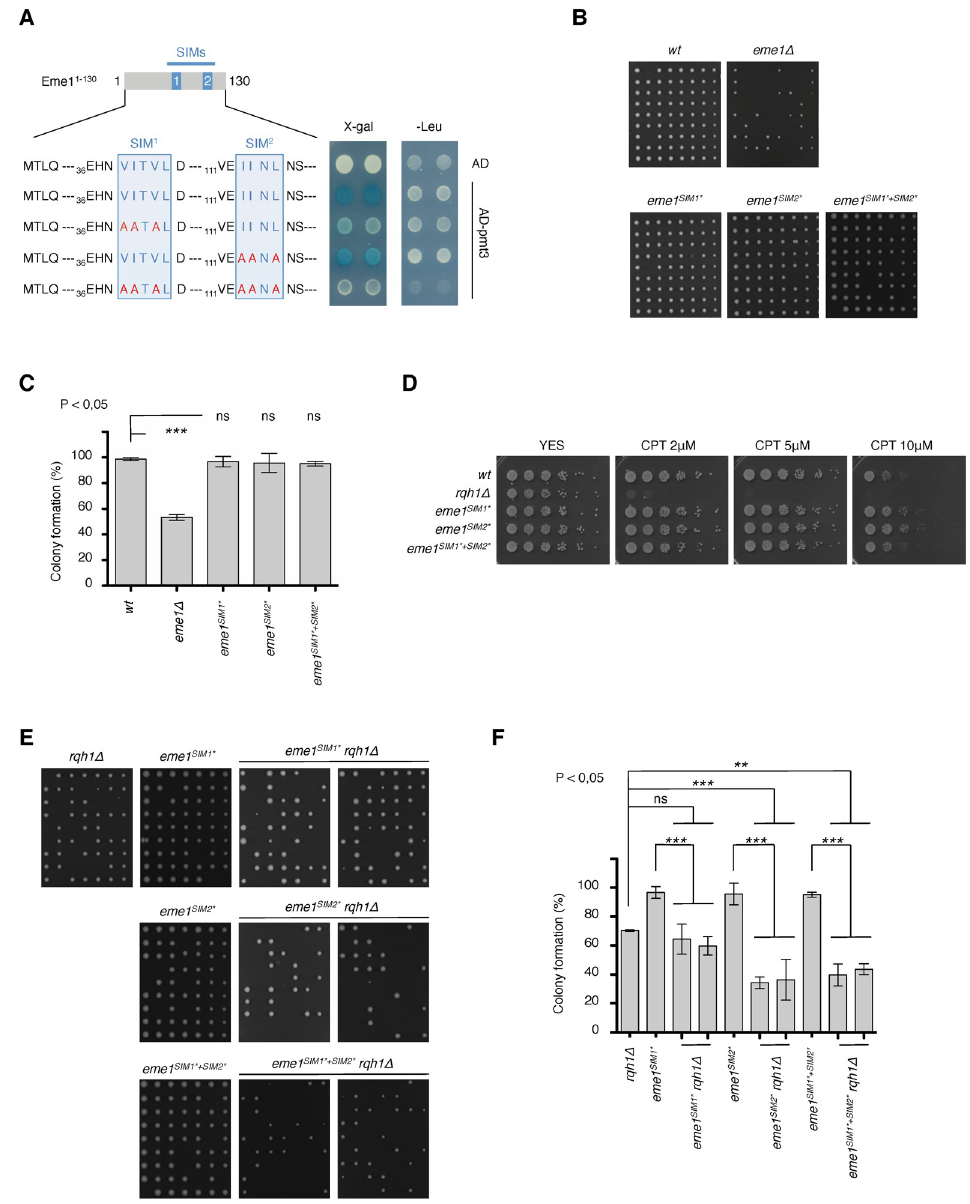
Fig 5. Eme1contains bona-fide SIMs. A- A fragmentof Eme1(eme1 1-130 ) containingSIM1andSIM2 wasusedas bait ina Yeasttwo-hybridassay for interaction withSUMO PMT3 . TheSIMsconsensussequencesare indicatedas wellas the mutations introducedin each of them.B- Exponentially growingwild type, eme1 Δ , eme1 SIM1 � , eme1 SIM2 � and eme1 SIM1 � +SIM2 � cellswere seeded onYES platesbymicromanipulation andallowedto growfor 3days at 32˚C. C-Averagepercentage( ± s.d.) of viable colonies (n = 3 independent experiments).Statistical significance is measuredwithone-wayANOVAfollowedbyTuckey post-test.D- Five-fold dilutionsof wild-type, rqh1 Δ , eme1 SIM1 � , eme1 SIM2 � and eme1 SIM1 � +SIM2 � cellswere plated onmedium supplementedornotwith theindicatedconcentrations of CPT followedbyincubationat 30˚C. E-Exponentially growing rqh1 Δ , eme1 SIM1 � , eme1 SIM2 � and eme1 SIM1 � +SIM2 � as wellas twoindependentclonesof eme1 SIM1 � rqh1 Δ , eme1 SIM2 � rqh1 Δ and eme1 SIM1 � +SIM2 � rqh1 Δ were seededon YESplatesby micromanipulationandallowedtogrow for3 daysat 32˚C. F- Average percentage( ± s.d.) of viable colonies(n = 3 independent experiments). Statisticalsignificance is measured withone-way ANOVAfollowedbyTuckey post-test.